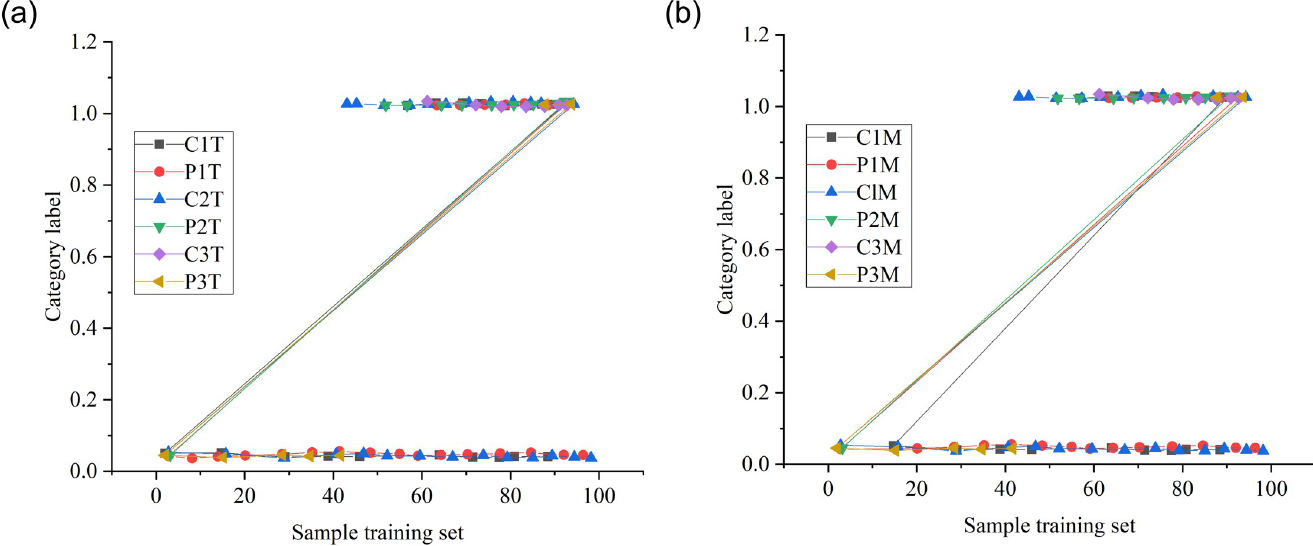
Fig 6. SVM model classification results (on a specific training process). ((a) SVM classification results on training set samples (b) SVM classification results on test set samples).